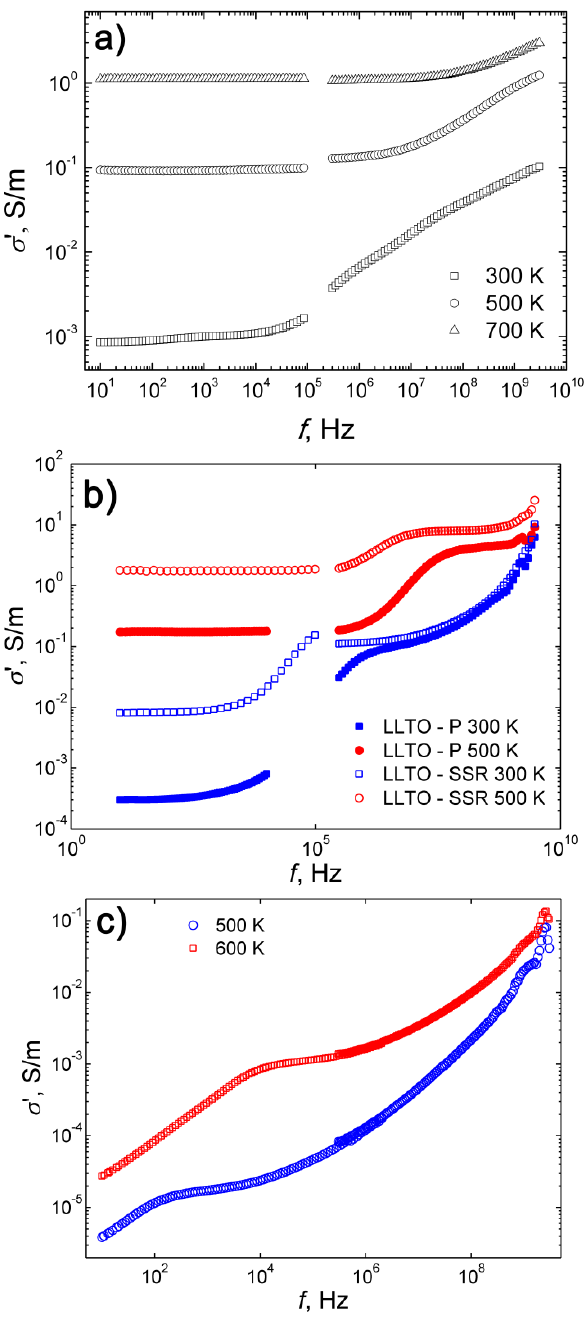
Figure 2: Frequency dependences of the real part of conductivity measured at different temperatures of Li 3 Ti 1.5 (PO 4 ) 3 (a), LLTO - P and LLTO - SSR (b), and 8YSZ